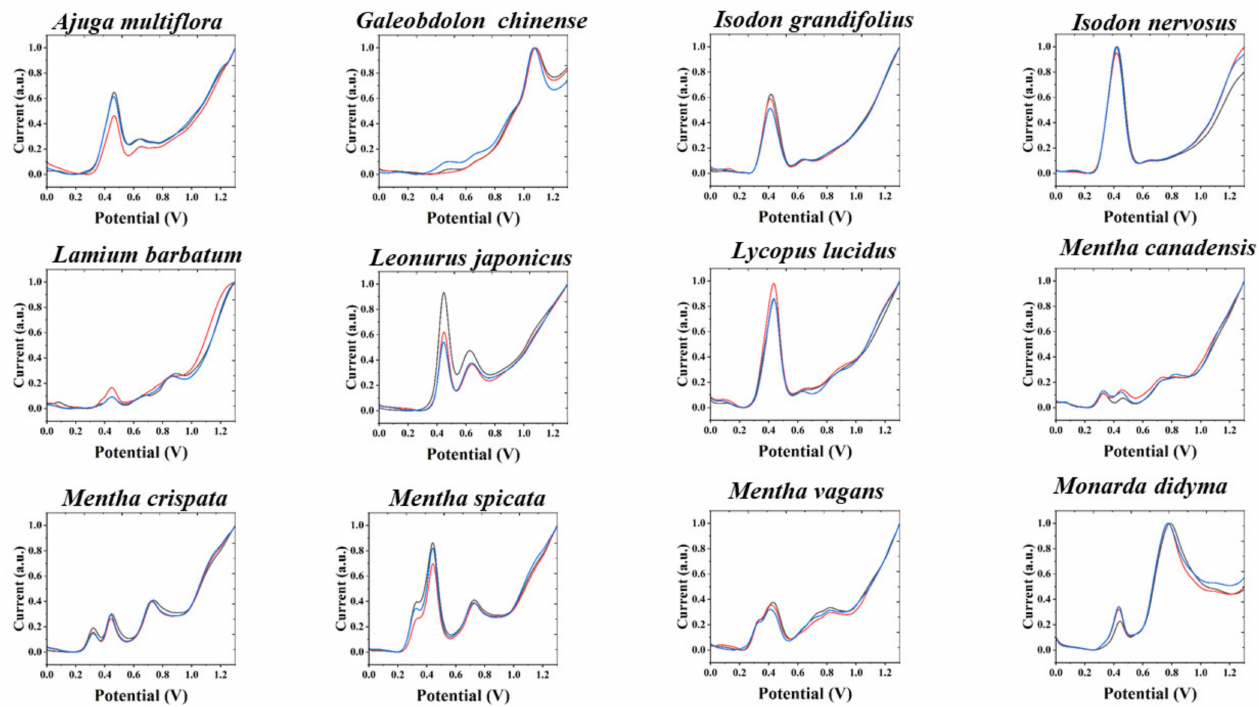
Figure 1. Electrochemical fingerprint of 12 species of Lamiaceae after water extraction and recorded under PBS condition (the remaining 24 species can be found in the Supplementary Information).